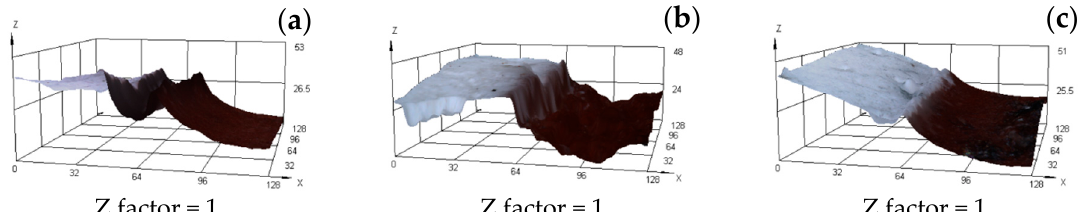
Figure 8. CLSM 3D images of typical fracture morphology: ( a ) TD0; ( b ) TD1.24; ( c ) TD2.45. The white part is tie-coating, the adjacent coating is epoxy primer.